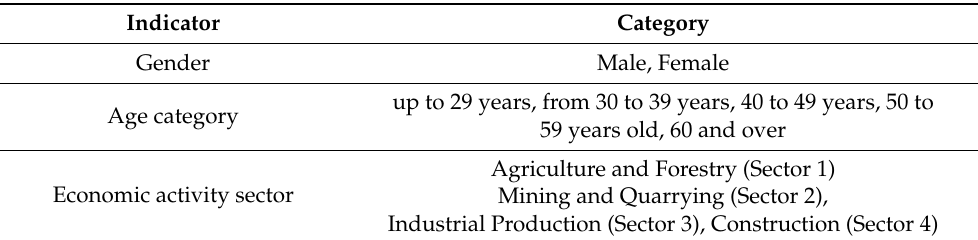
(Table 4): the gender of workers (two subcategories), the age category (five subcategories) and the sectoral classification of economic activities (four subcategories). Table 4. Overview of indicators and